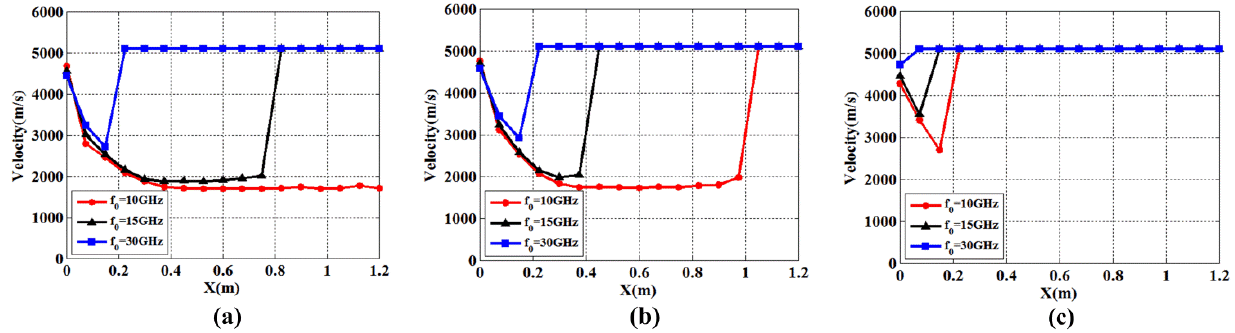
Figure 13. The velocities on the reflective surface of plasma sheath in scenes 1, 2, and 3. ( a ) Altitude is 30 km. ( b ) Altitude is 40 km. ( c ) Altitude is 50 km.